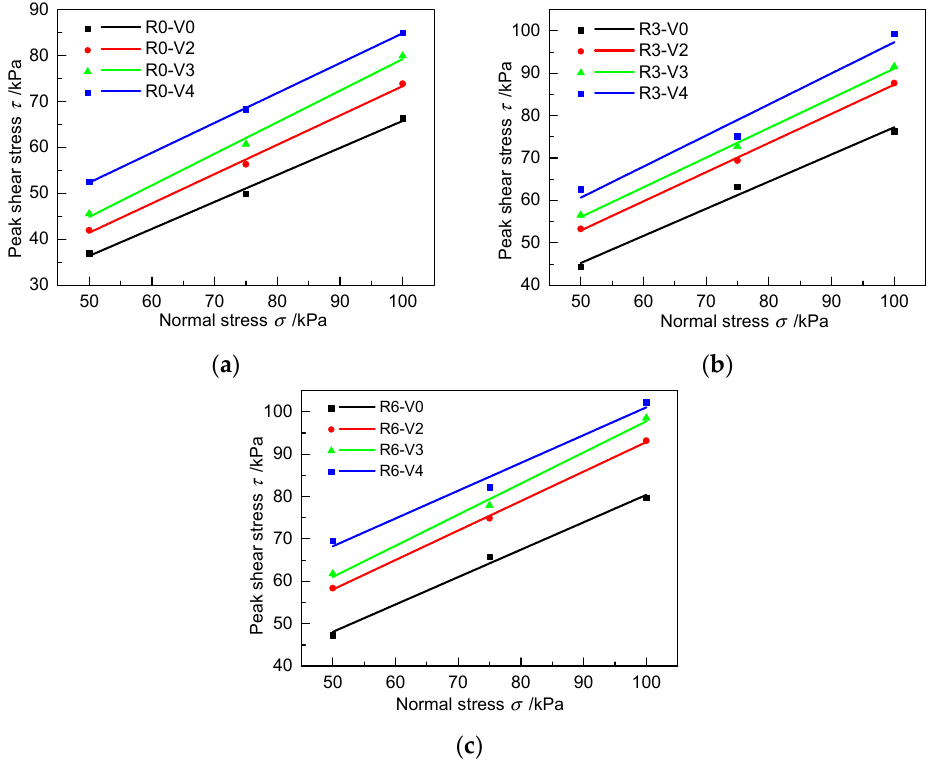
Figure 11. Fitted curves between peak shear stress and normal stress with different grouting volumes for different roughness values: ( a ) R0, ( b ) R3, and ( c ) R6.